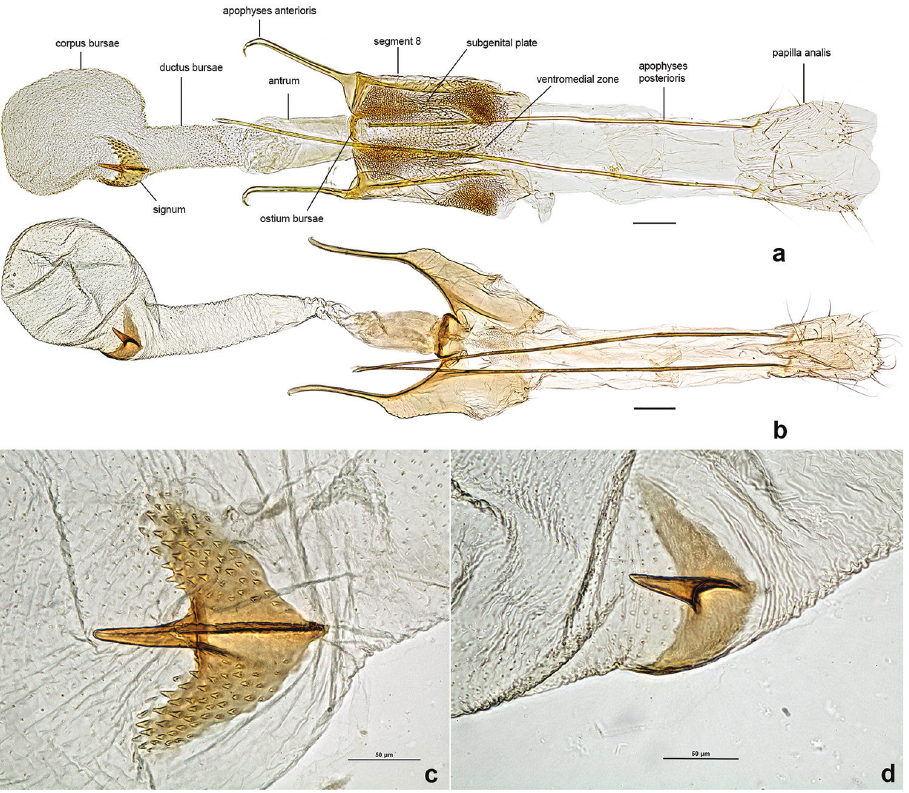
Figure 5. Female genitalia of Neopalpa species. a N. neonata (CNCLEP00077350, dissection MIC6530; CA: Santa Cruz Island) b N. donaldtrumpi sp. n. (UCBMEP0201482, dissection VNZ241; CA: Impe- rial County); Close-up of signa c N. neonata (UCBMEP0201495, dissection VNZ239; CA: Imperial County) d N. donaldtrumpi sp. n. (same as b). Scale bar 100